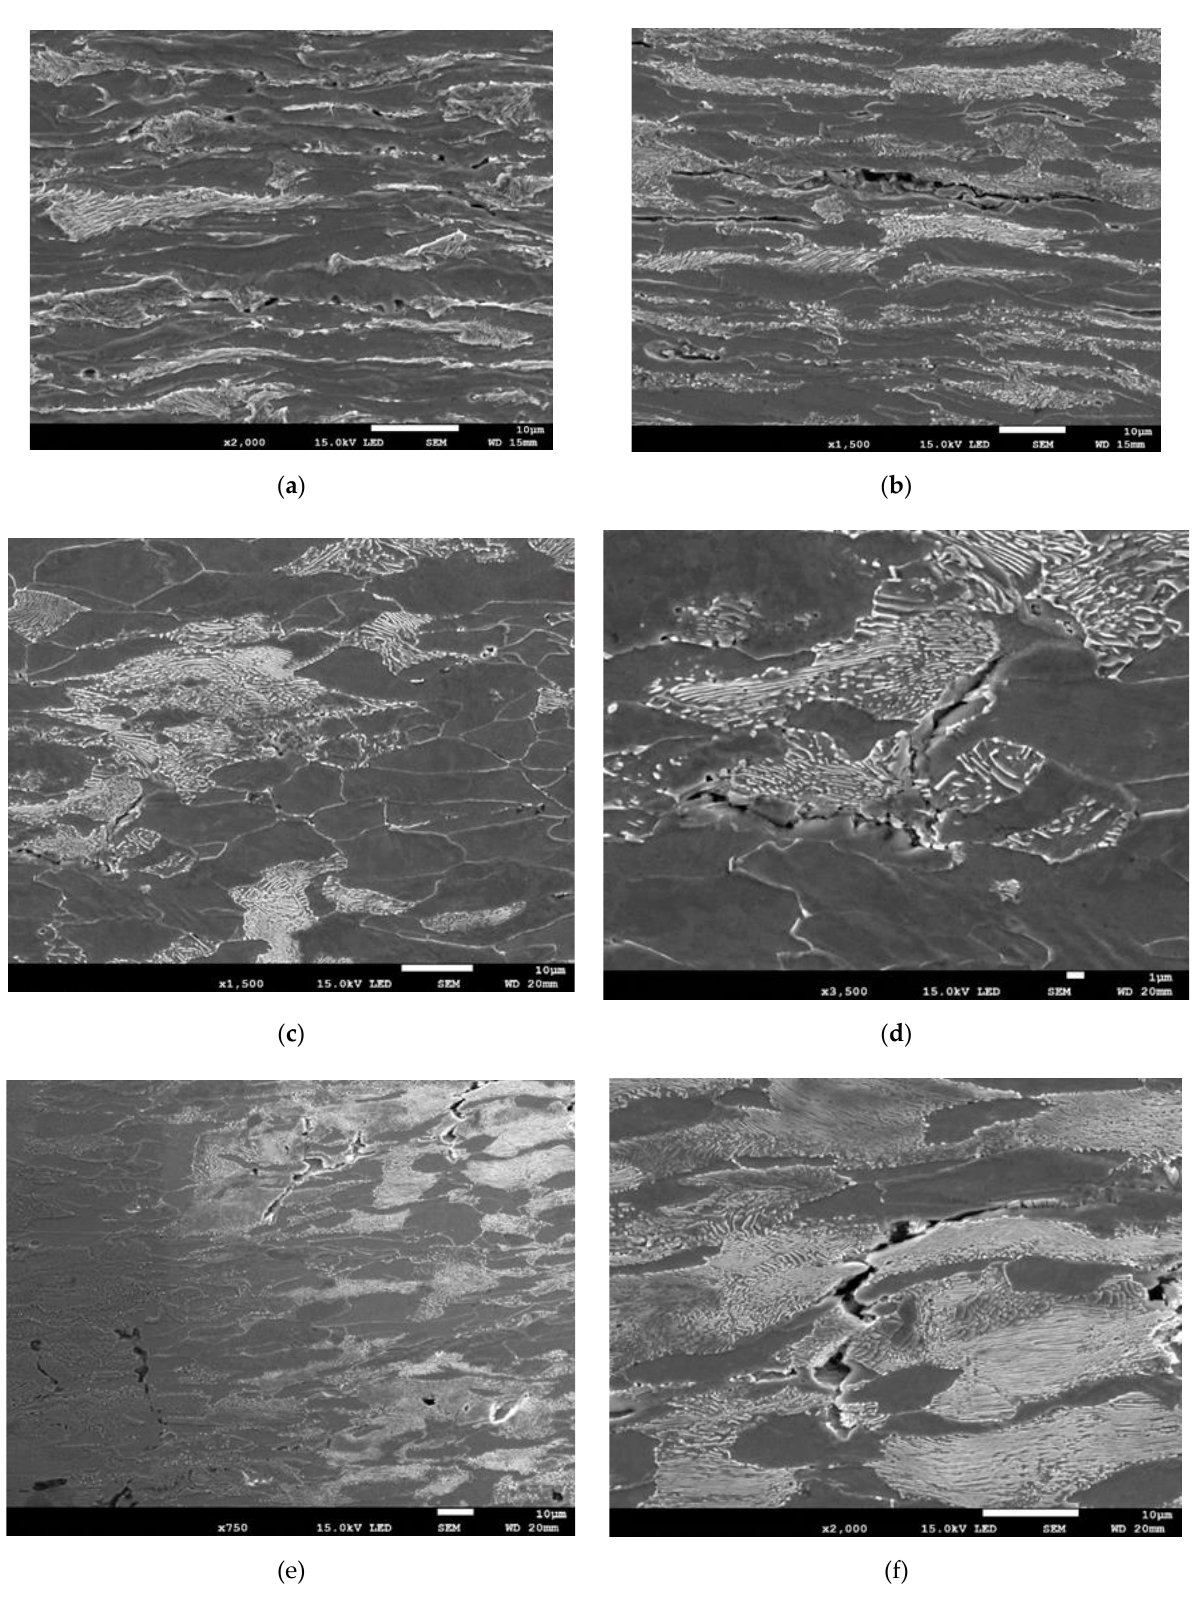
Figure 8. Nature of material damage in the specimen neck: ( a – d ) middle stage of neck formation; ( e , f ) final stage.